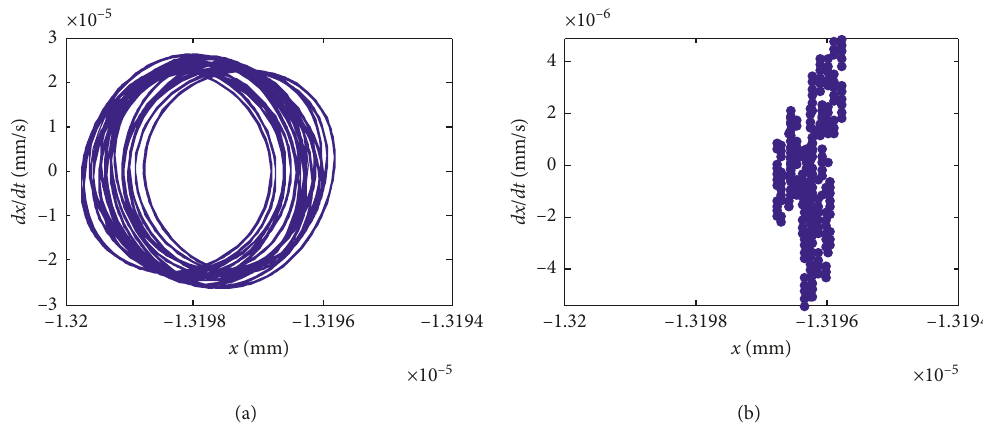
Figure 5: System response for ω � 15000r/min. (a) Phase portraits. (b) Poincar´e map.